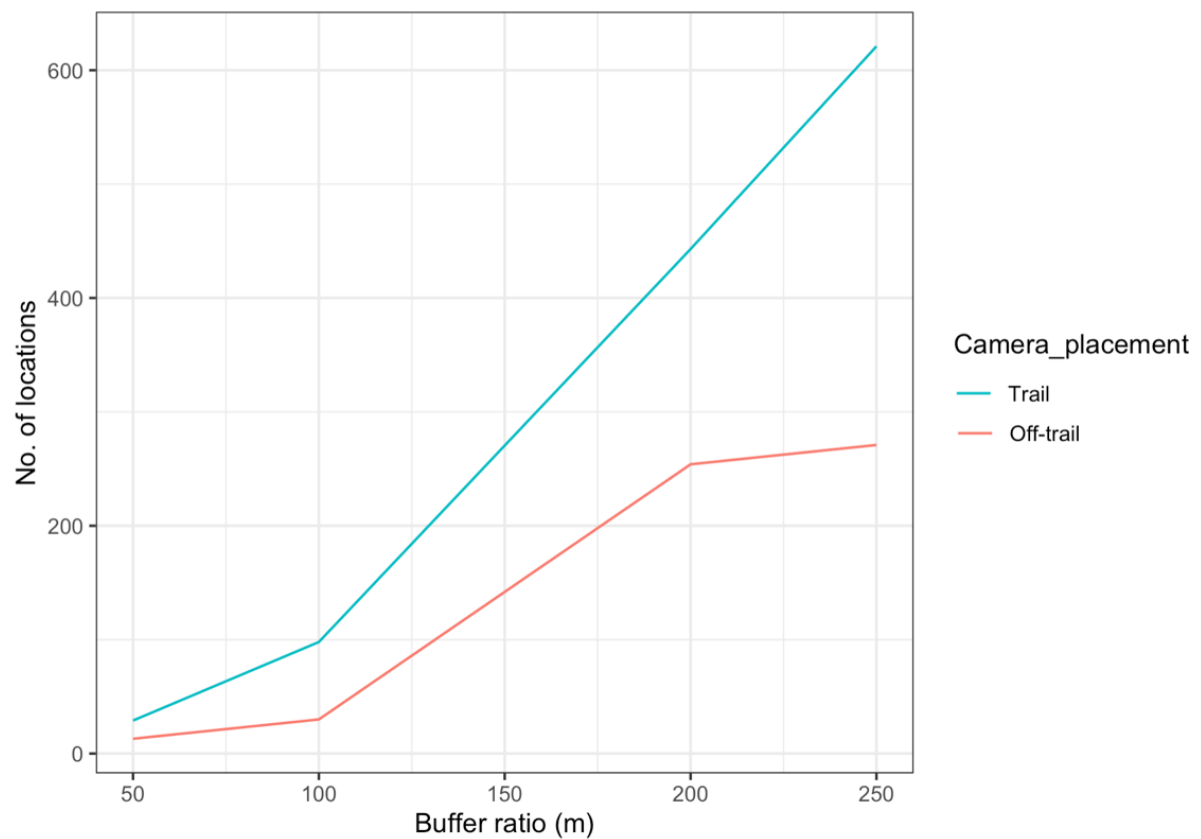
Figure 8. Number of satellite telemetry locations of a collared female jaguar, located within multiple buffer ratio distances around camera location placements (trail/off-trail) in Sector Santa Rosa, Guanacaste Conservation Area, Northwestern Costa Rica.